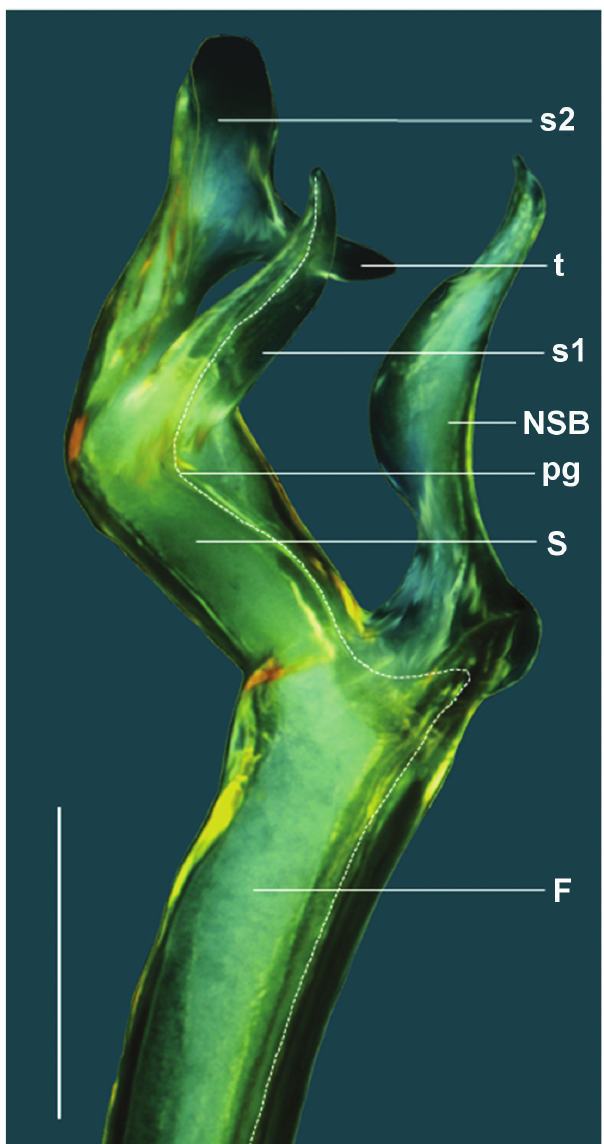
Figure 4. Taxidiotisoma portabile sp. n., holotype male (AM KS. 94041), detail of left gonopod tip, anterior view. Abbreviations: F femorite, NSB non-seminiferous branch, S solenomere, s1 process with prostatic groove, s2 cowl-shaped process, pg prostatic groove, t tooth. Dotted line denotes path of prostatic groove. Scale bar: 0.2